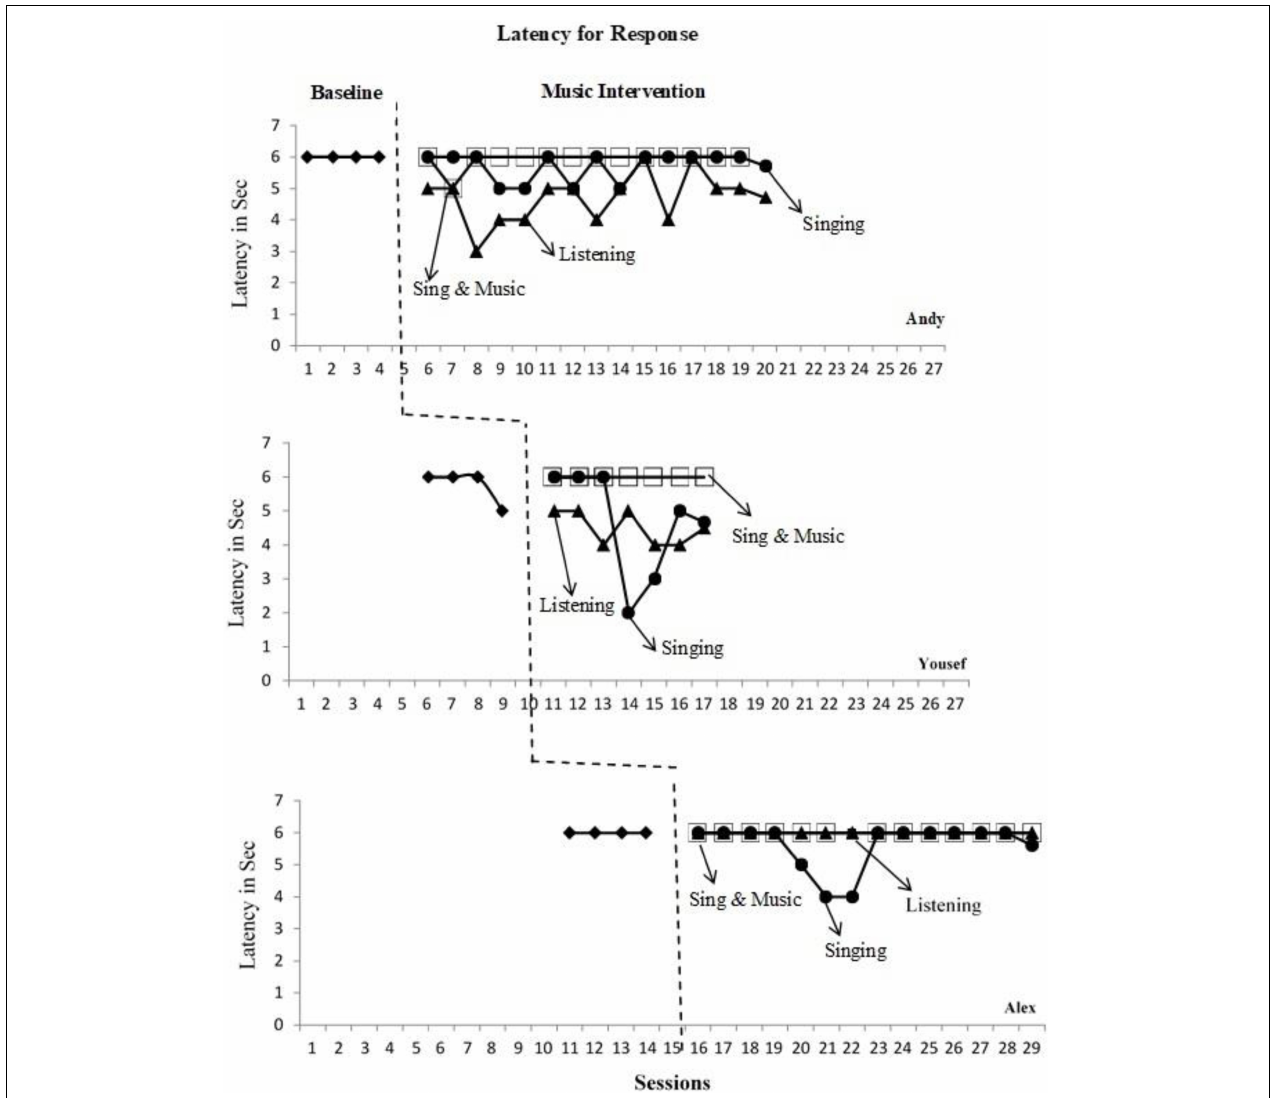
FIGURE 2 | Latency of response scores reported in number of